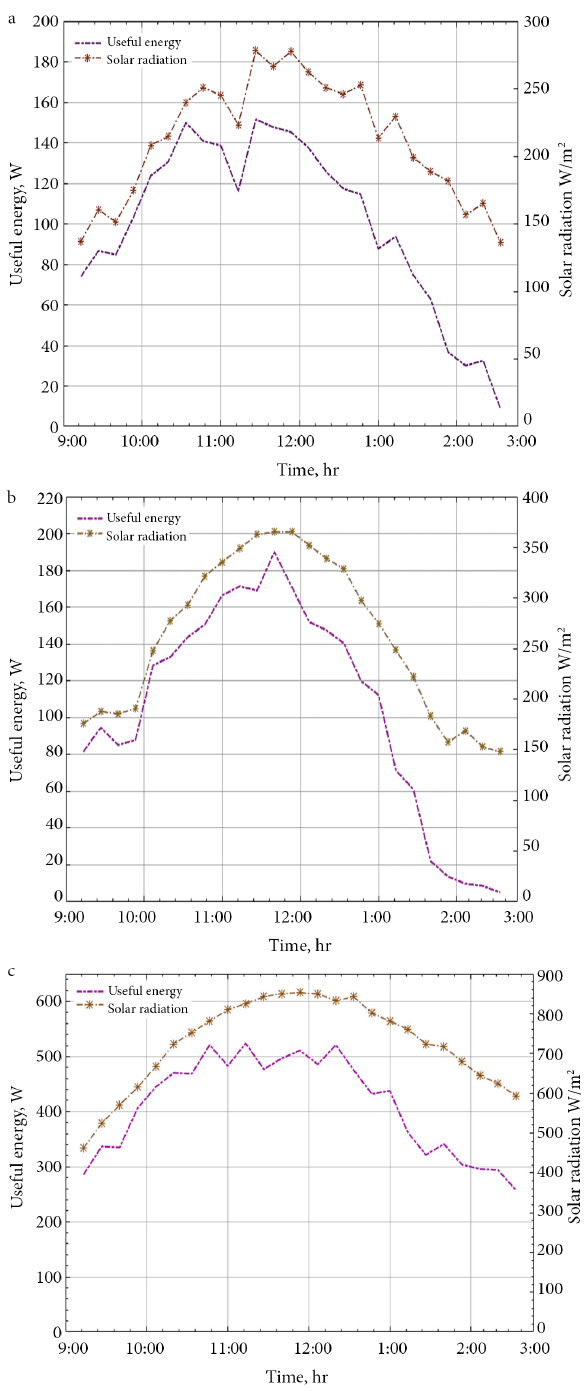
Figure 10. Electrical power output variation and measured solar radiation histories on: a − Nov. 28 th